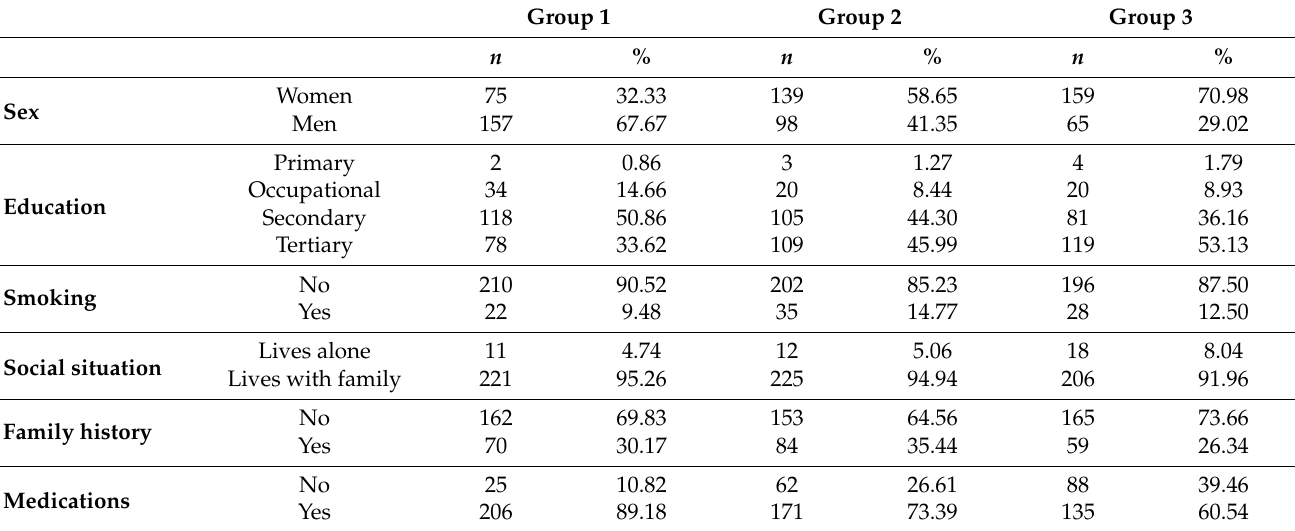
Table 2. Baseline characteristics (categorical variables) for the three groups yielded by cluster